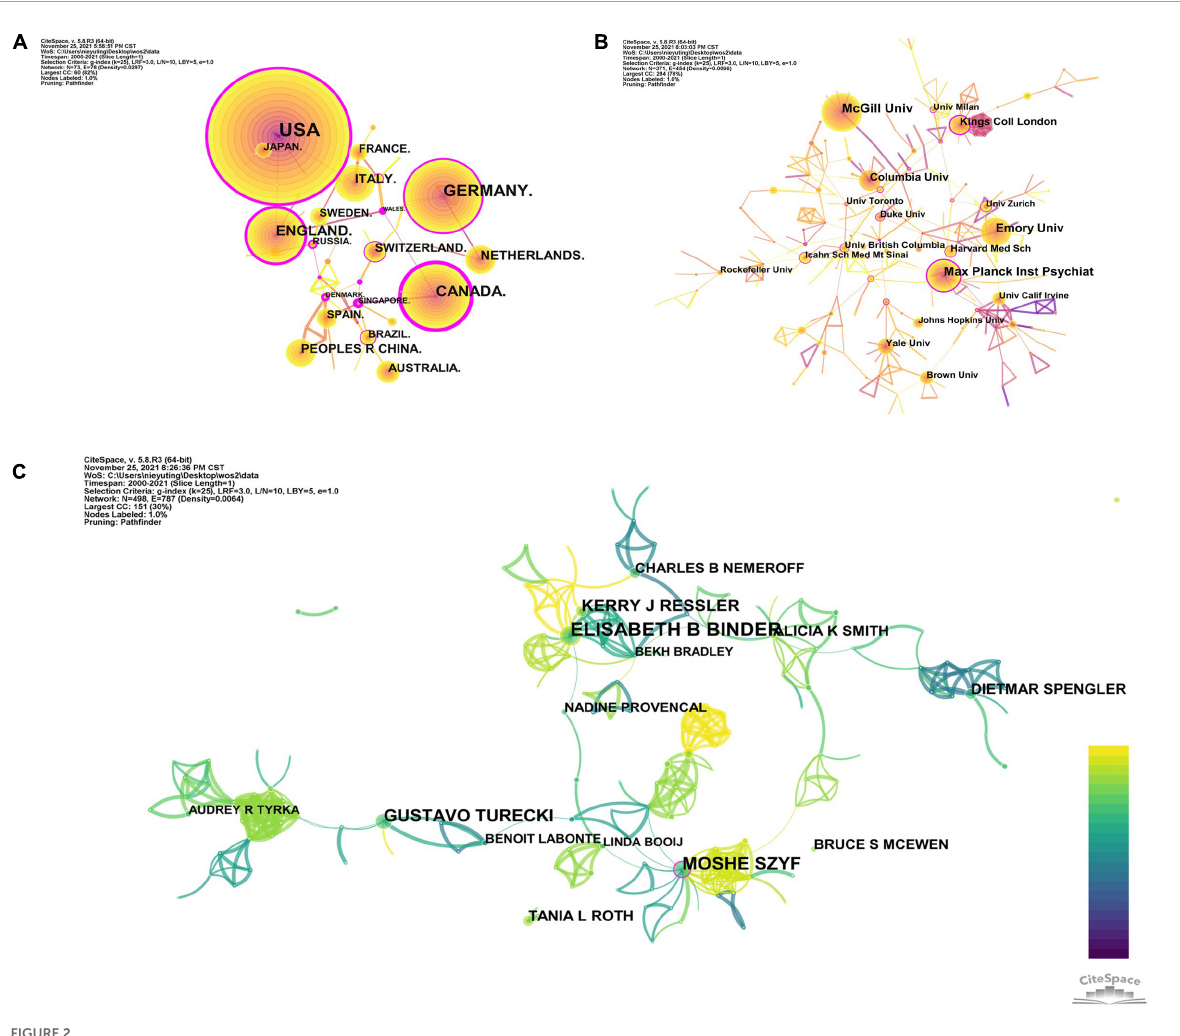
FIGURE2 (A) Collaboration among countries/regions. (B) Collaboration among institutions. (C) Collaboration among